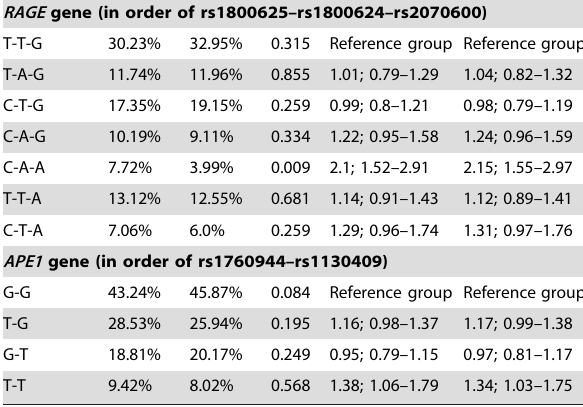
Abbreviations : OR, odds ratio; 95% CI, 95% confidence interval. Psim: simulated P-value, which was calculated based on randomly permuting the trait and covariates and then computing the haplotype score statistics.